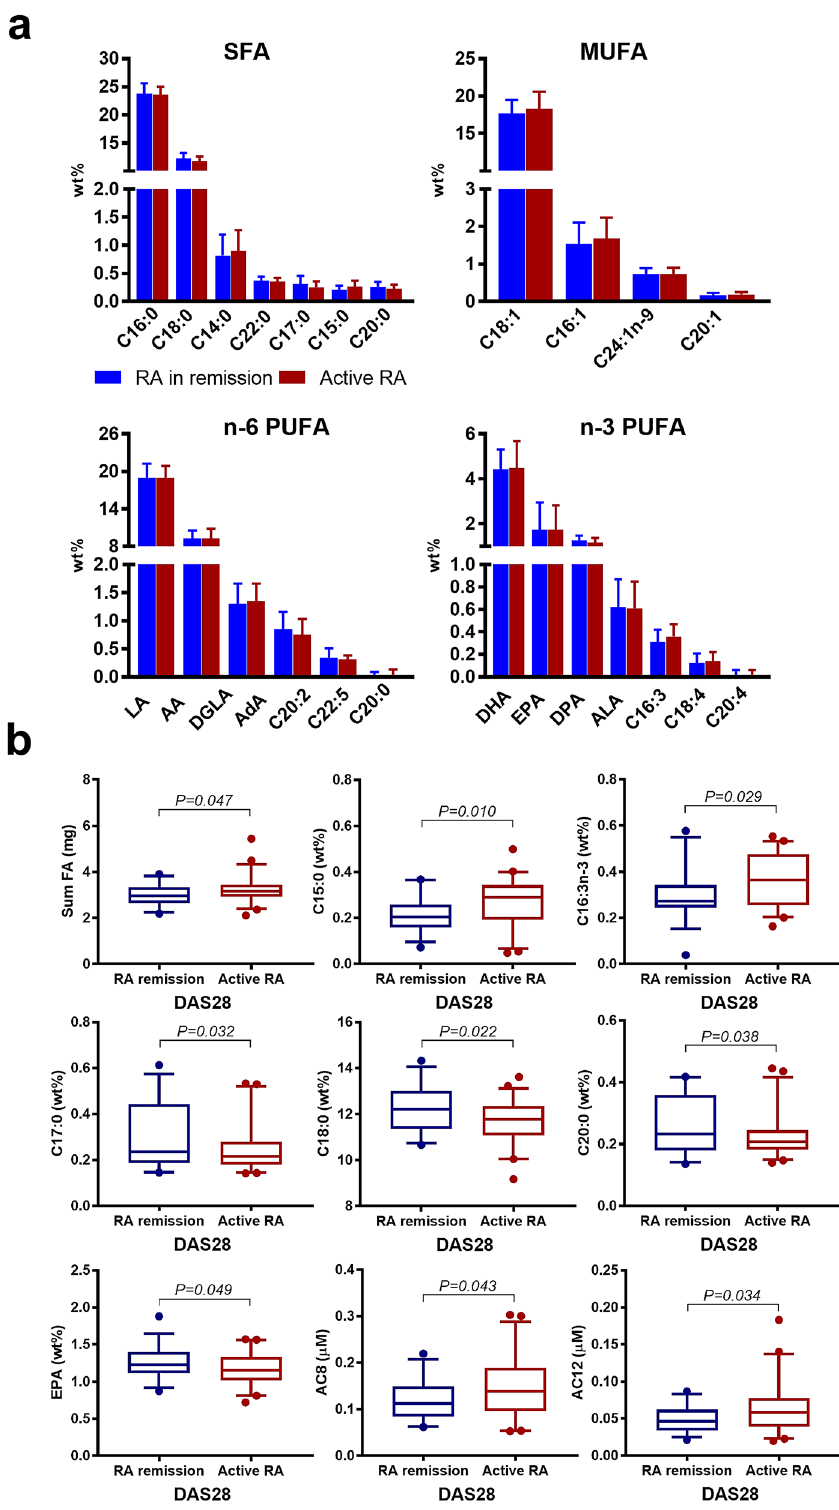
Figure 2. Association between whole blood FA, serum lipids, serum carnitine- and choline derivatives and RA disease activity. ( a ) Columns show relative FA concentrations (mean ± SD) grouped by RA disease activity, DAS28 score ≤ 2.6 = RA in remission (N = 33, coloured in blue) or DAS28 ≥ 2.6 = active RA (N = 45, coloured in red) and by chemical classification (SFA, MUFA, PUFA n−6, PUFA n−3) sorted from high to low abundance. ( b ) Boxplots show FA, lipids, and carnitine- and choline derivatives significant associated with RA disease activity status (RA in remission (N = 33, coloured in blue, active RA (N = 45, coloured in red). The boxplots show medians, the error bars indicate 5–95% confidence interval. The connectors show statistically significant differences, P < 0.05. P values are based on Student